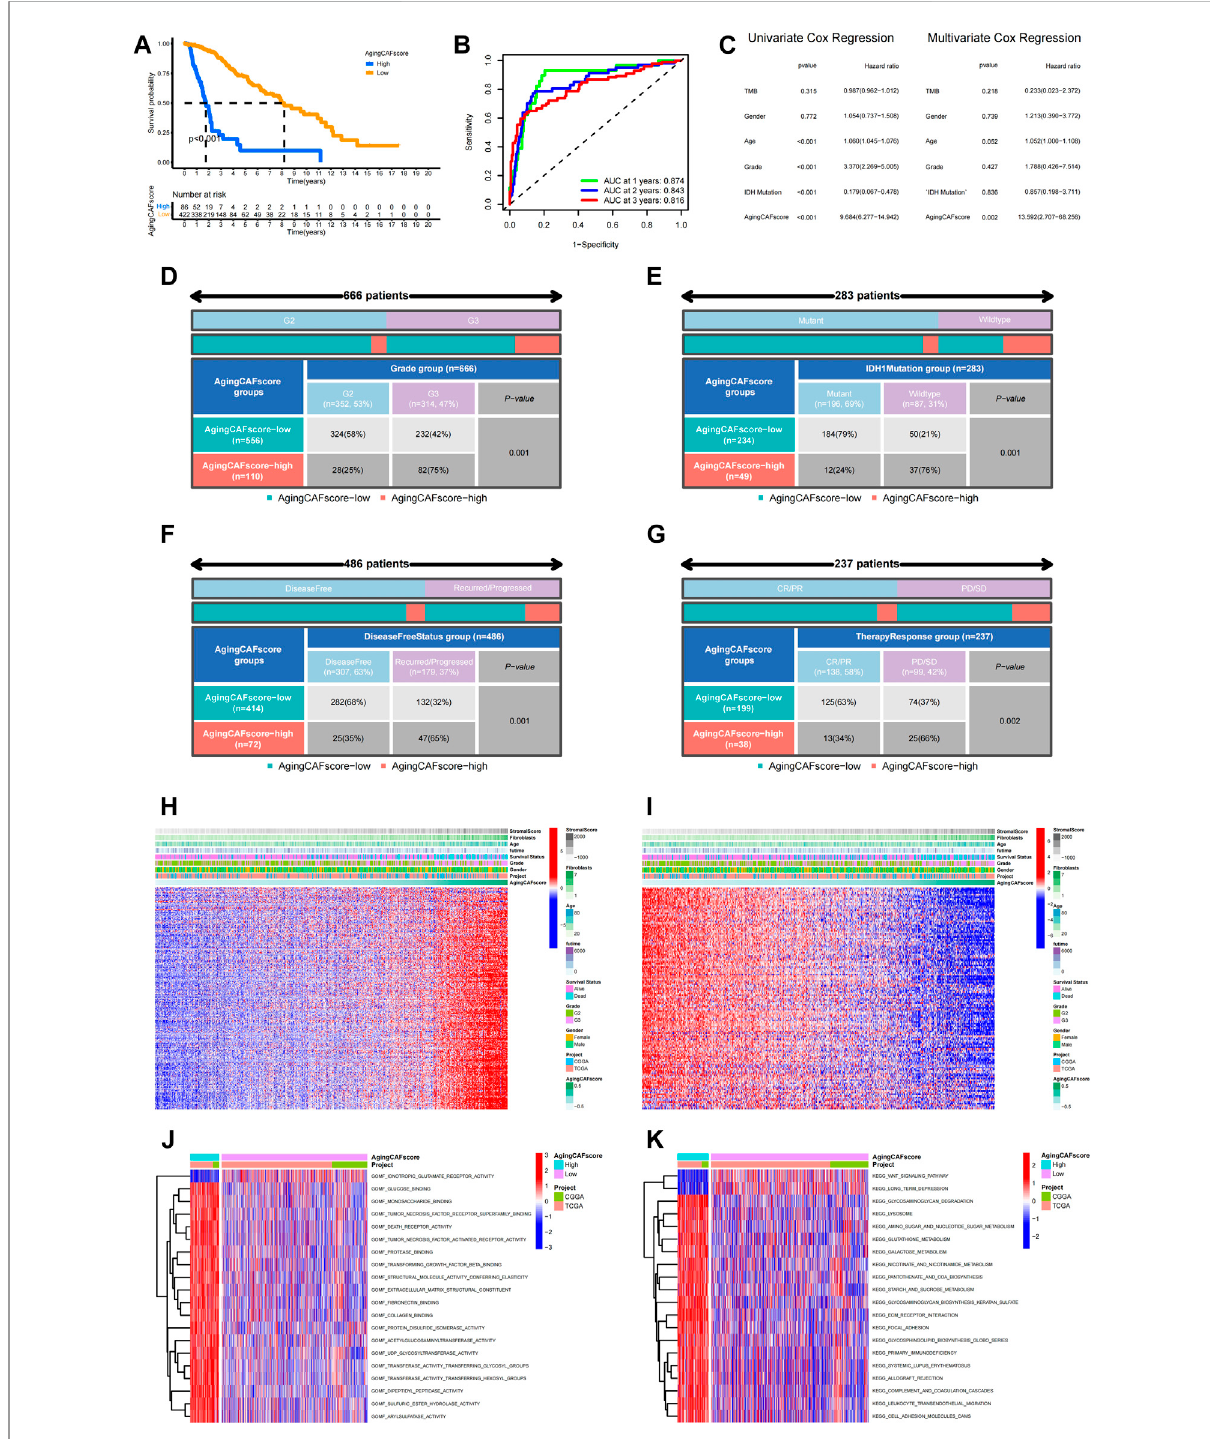
FIGURE 4 Comparison of the prognosis between low- and high-aging CAF score groups. (A) Kaplan – Meier survival analysis demonstrated that the high- aging CAF score group had a worse prognosis than the low-aging CAF score group in TCGA cohort ( p < 0.001). (B) Time-dependent ROC curves of the aging CAF score in TCGA cohort. (C) Univariate/multivariate Cox regression analysis of the aging CAF score in TCGA cohort. (D – G) Correlation analysis betweentheaging CAFscore groupandgrade (D) ,IDH1mutationstatus (E) ,disease-freestatus (F) ,andconventionaltherapyresponse (G) .All p -valueslessthan0.05. (H) HeatmapshowingtheexpressionpatternsofunfavorableACAFRGswithincreasingagingCAFscores. (I) Heatmap showing the expression patterns of favorable ACAFRGs with increasing aging CAF scores. (J) Differentially enriched molecular functions